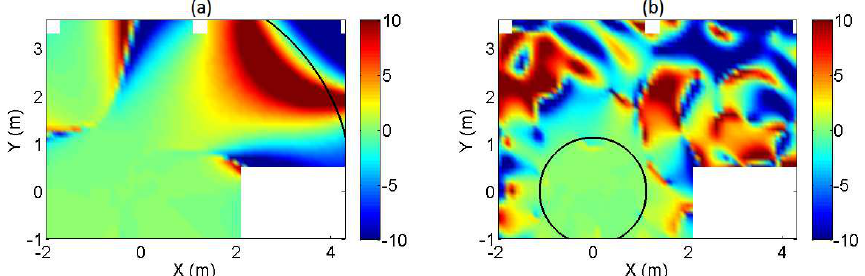
Figure 10. Amplitude error of the reference room at 63 Hz ( a ) and 250 Hz ( b ), regularized β = 0.33.